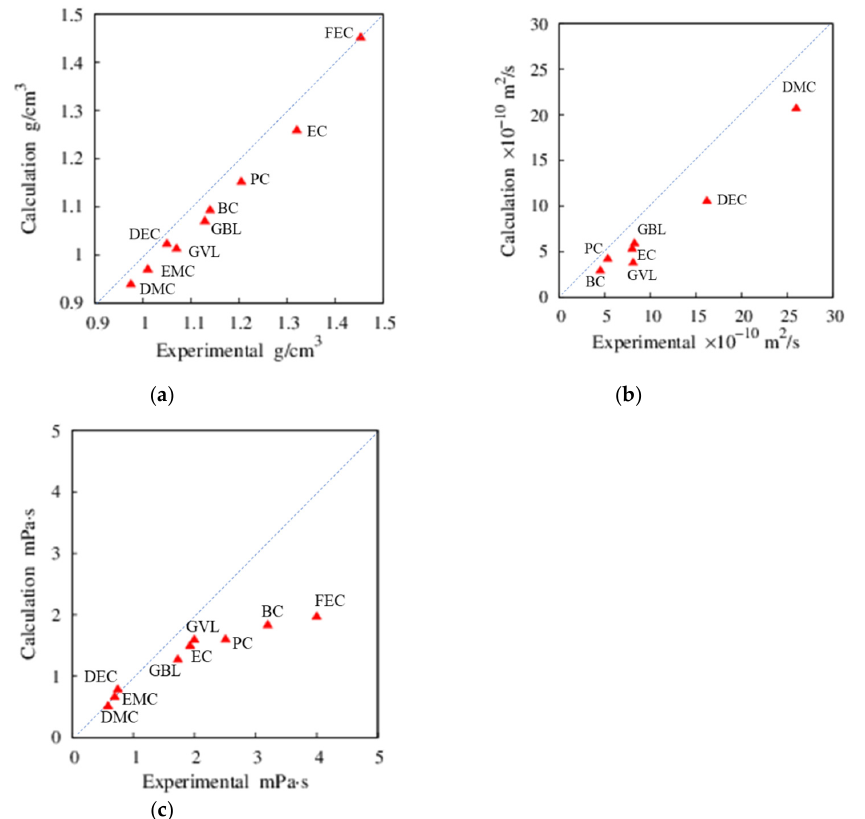
Figure 2. Correlations of physical properties between molecular simulations and experiments (dashed lines represent the equivalence between computations and experiments). ( a ) For density [44,45]; ( b ) for diffusion coefficient [46,47]; ( c ) for viscosity [46,47].